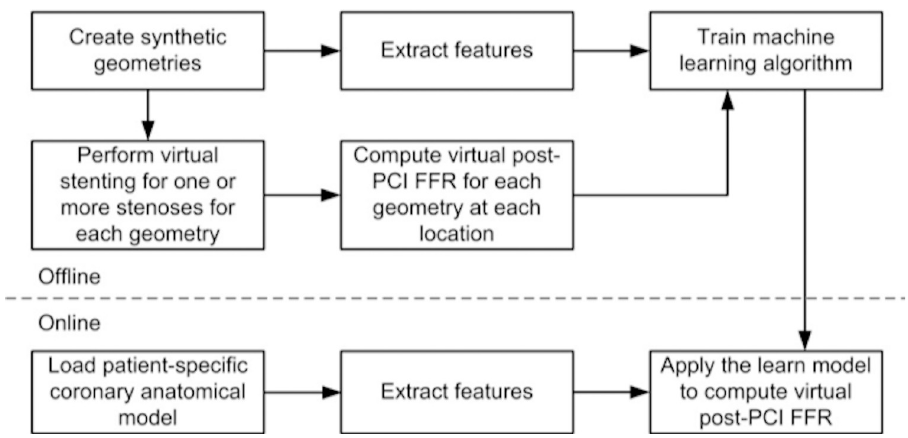
Fig 3. Approach for artificial intelligence based virtual post-percutaneous coronary intervention fractional flow reserve (FFR) computation.